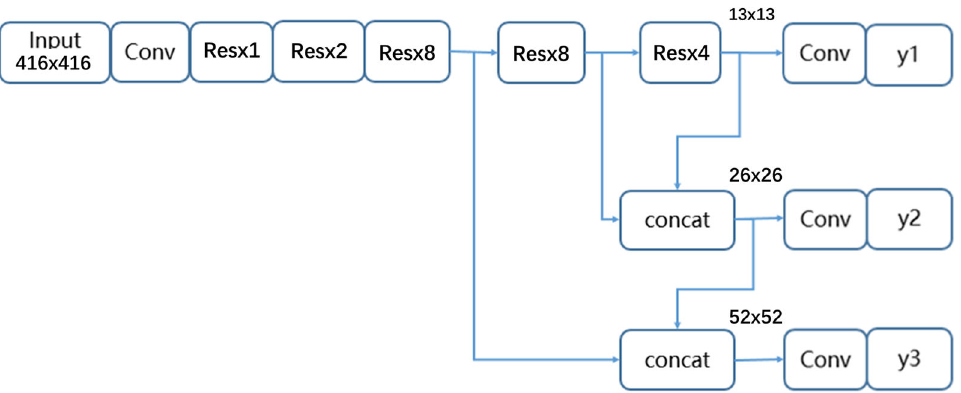
Figure 3. The architecture of YOLOv3. The “Conv” unit represents the common convolutional layer. The “Res” unit represents the shortcut structure borrowed from ResNet. It contains two convolutional layers and one residual layer. “x8” means this unit will repeat eight times. “concat” represents the concatenation layer, which can concatenate two inputs at the channel dimension. Units y1, y2, and y3 represent three detection layers.